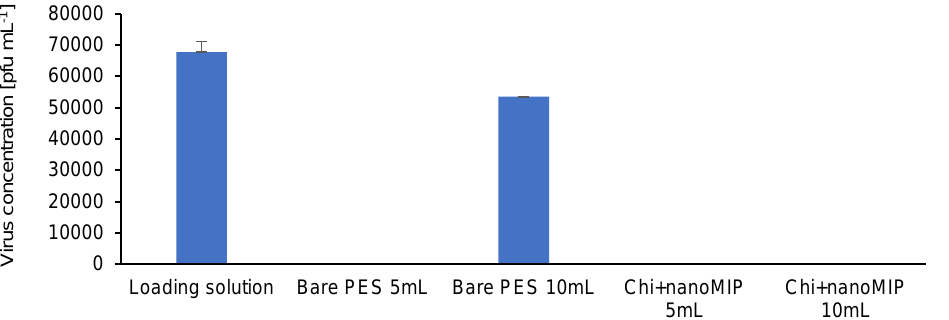
Figure 11. Virus concentration of the loading solution, permeates of bare PES membranes and permeates of bioselective chitosan + nanoMIP functionalized PES membranes.